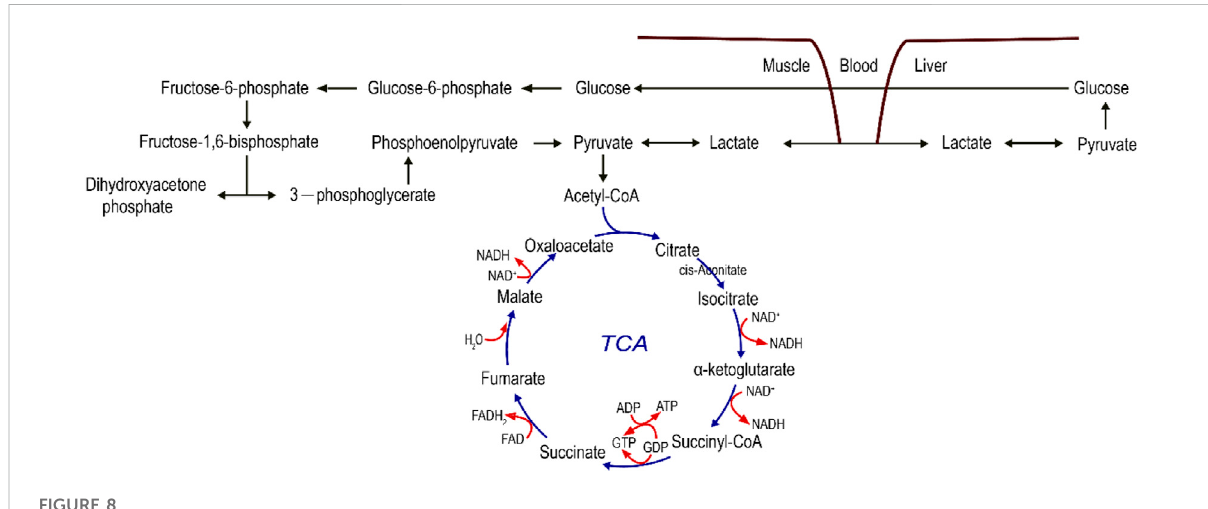
FIGURE 8 Pathways of related energy